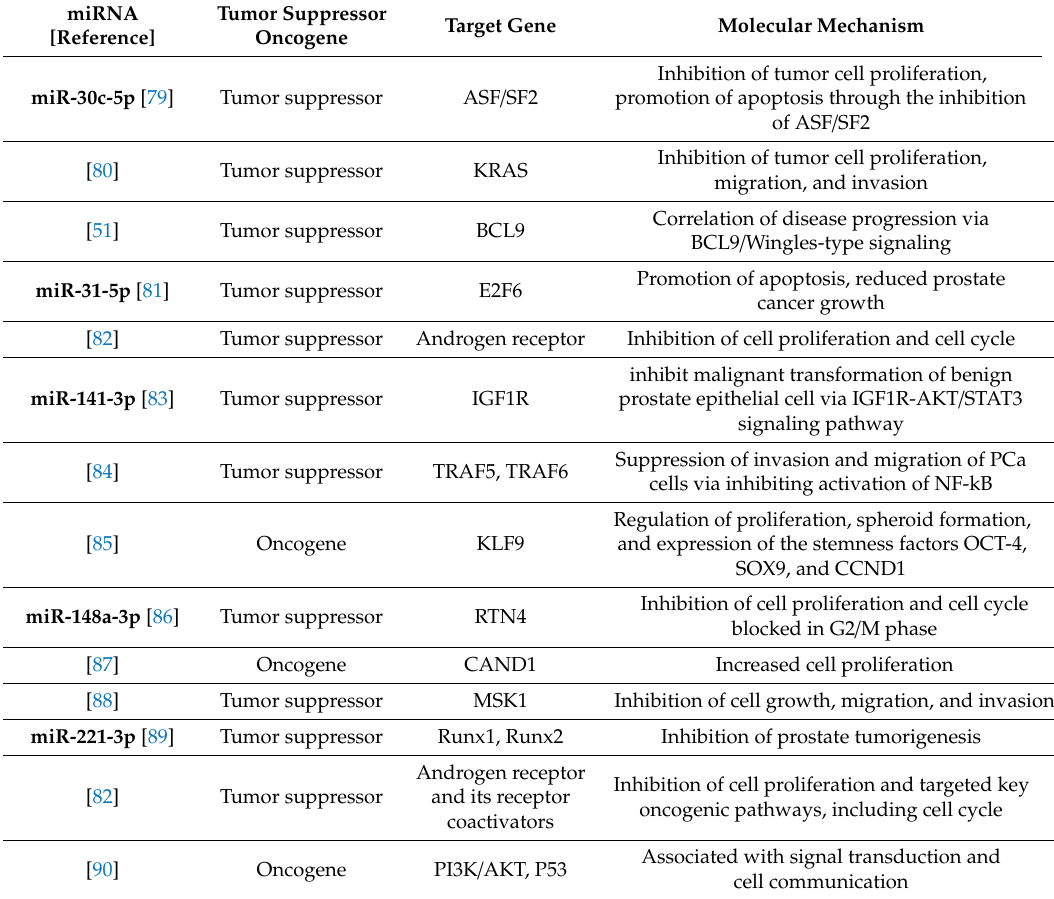
Table 8. Functional links between miRNAs of the five-miR-panel and prostate